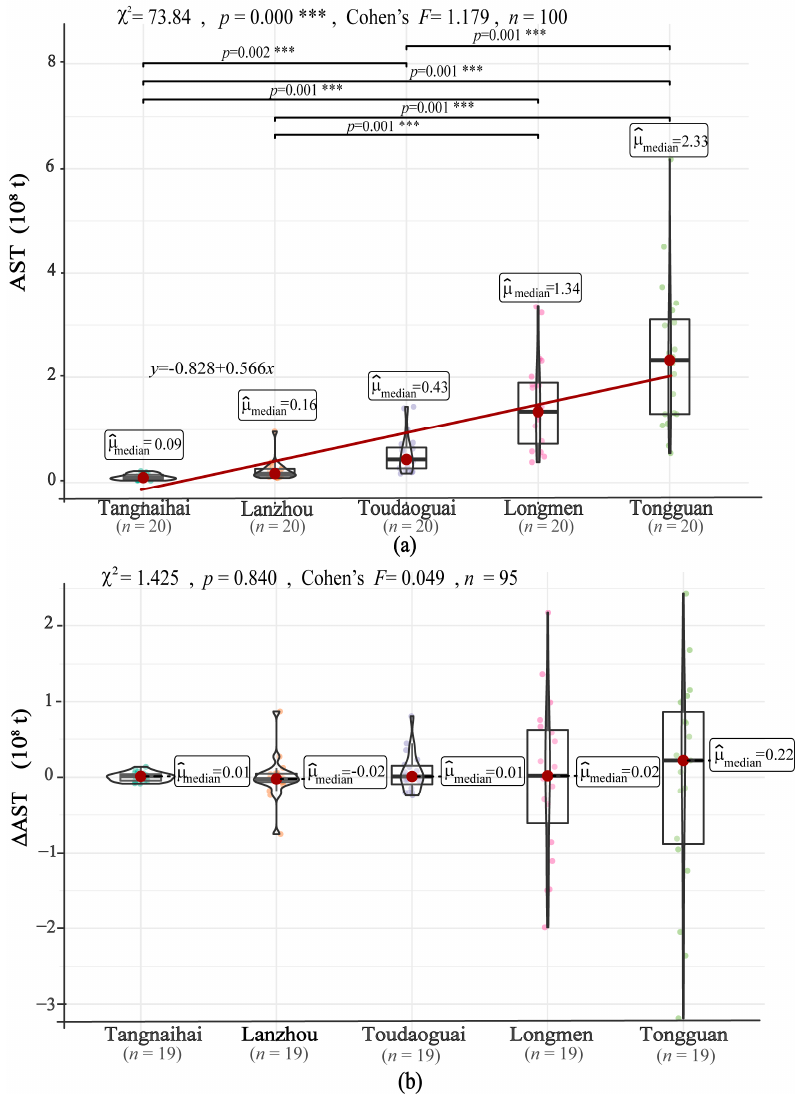
Figure 4. Friedman test of AST ( a ) and ∆ AST ( b ) at the five gauge stations. The abbreviations, AST and ∆ AST, denote the annual sediment transport and the amount of interannual variation in the annual sediment transport, respectively. The red line in ( a ) is the trend line for the annual mean sediment transport (2001–2020) at each gauge station. The symbol ‘***’ indicates that there is a signi fi cant di ff erence between the two gauge stations.